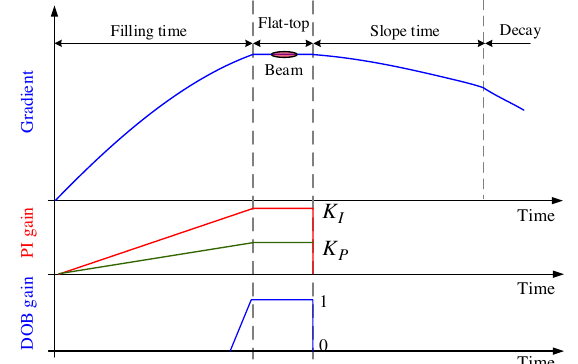
FIG. 13. Activation time of each PI control and DOB